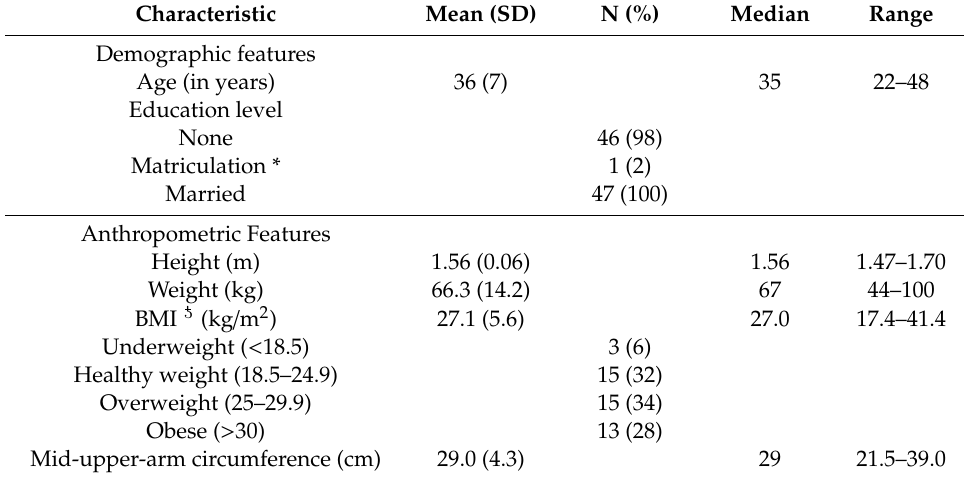
Table 1. Participant characteristics (n =